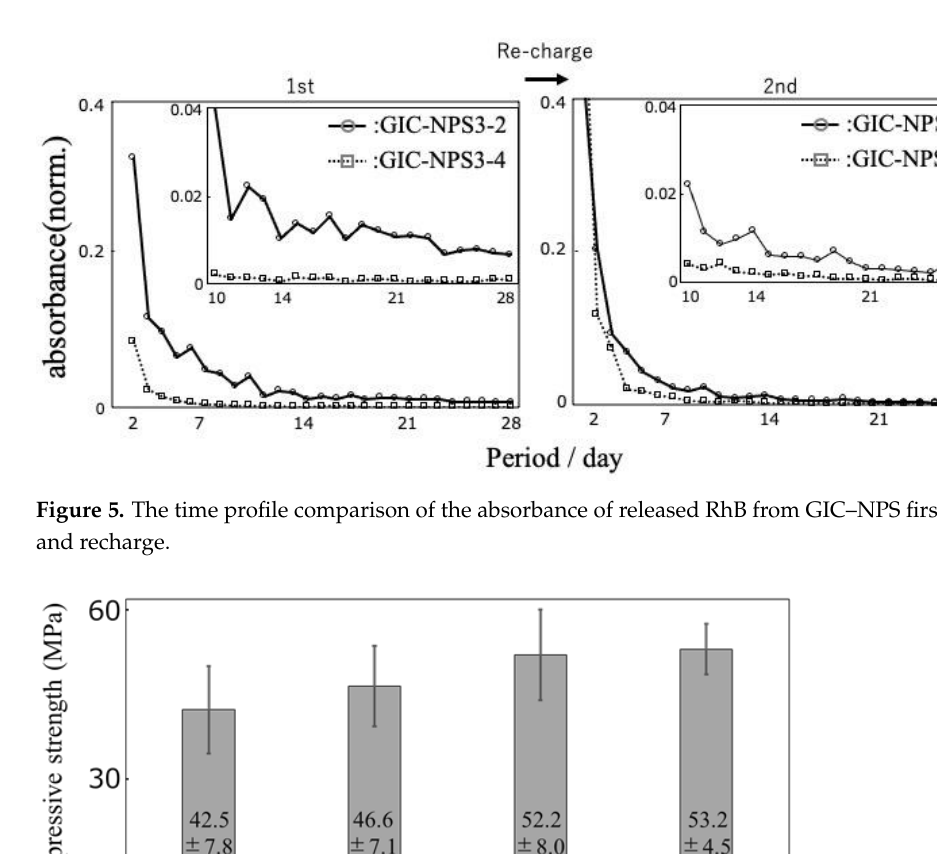
5 of 9 Figure 4. Color change of GIC-NPS3-2 and GIC-NPS3-4 supernatant under ultraviolet light during